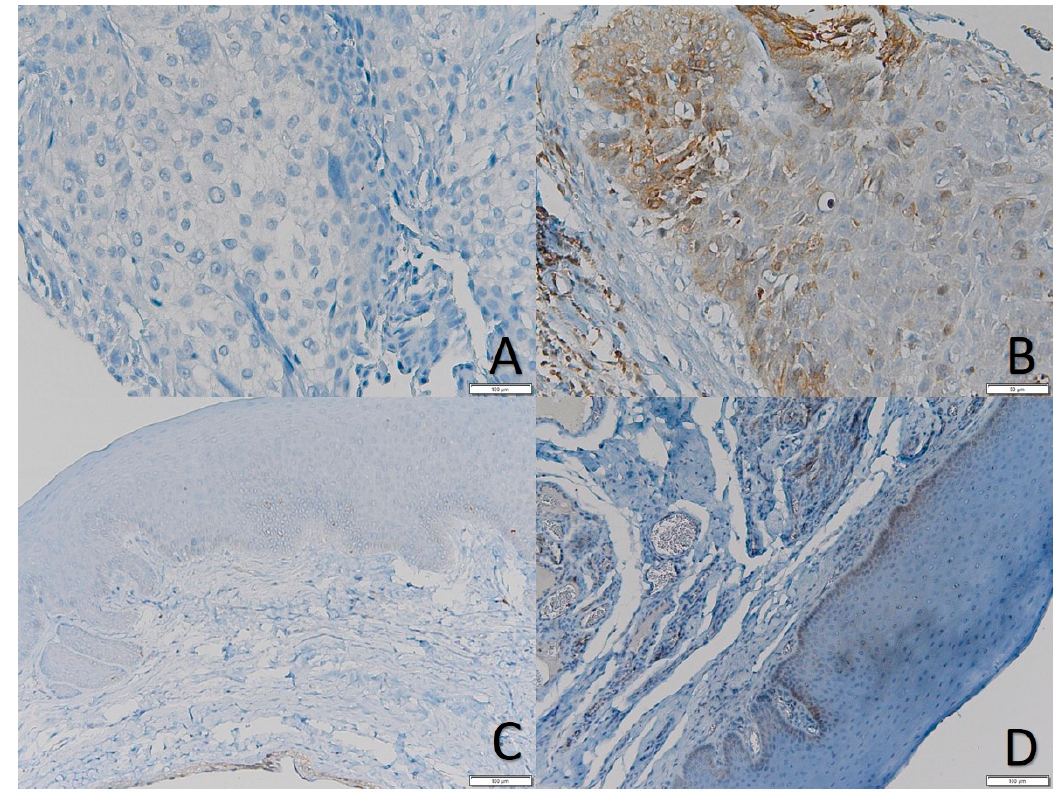
Figure 1. ( A ) Negative OSCC for MSI2; ( B ) Basal MSI2 positivity intensity + 2; ( C ) 40% Normal mucosa negative for MSI2 with mild positivity in a ductal epithelium; and, ( D ) normal mucosa mild positive for MSI2 in the basal layer.